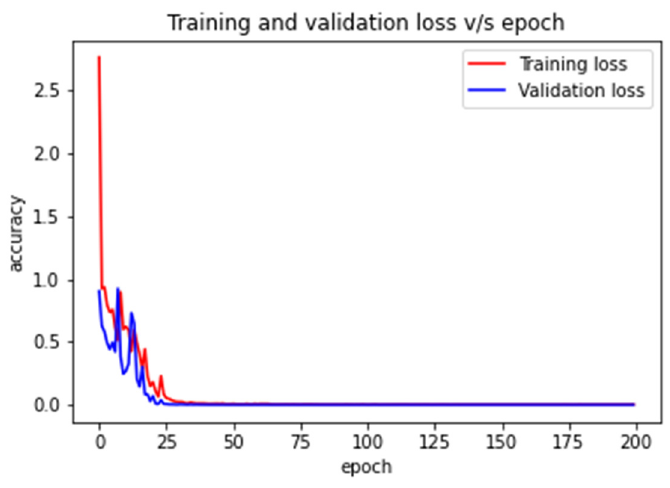
Figure 12. The proposed TL-based FDD approach’s loss curve using welding motion.